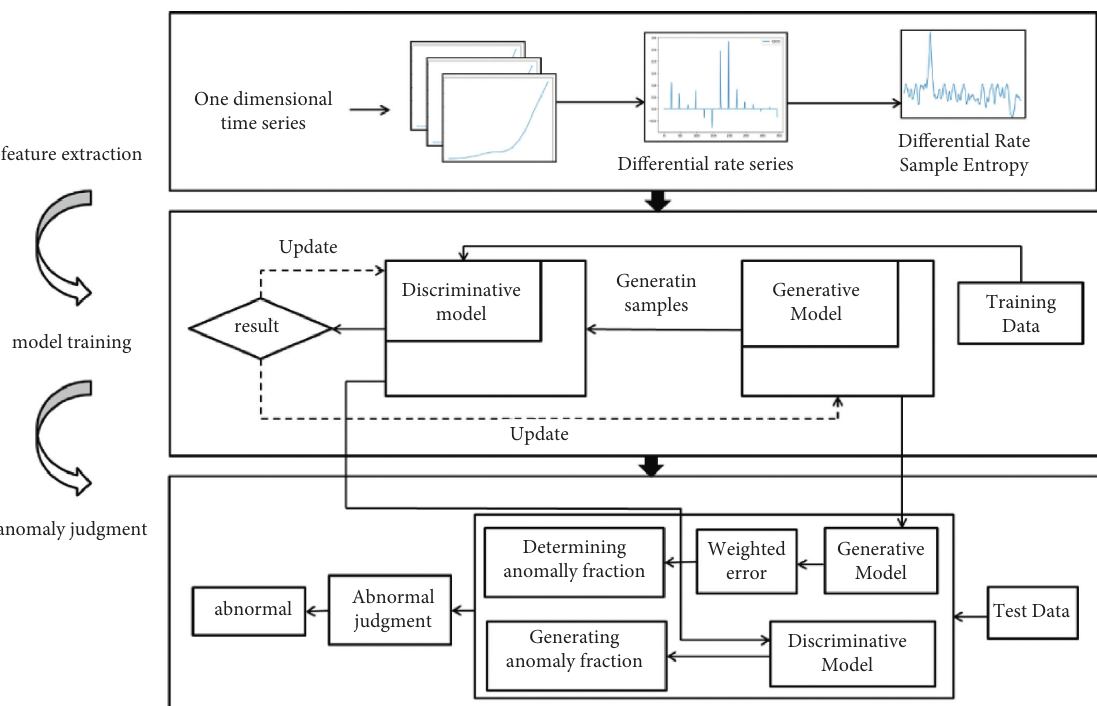
Figure 5: Overall flowchart of anomaly